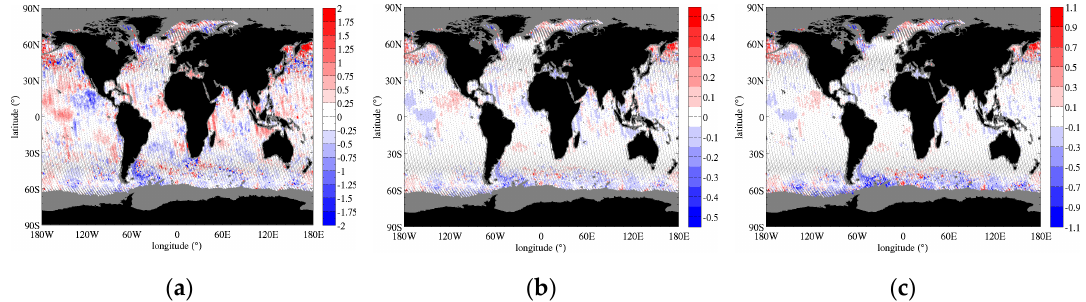
Figure 6. Impact of SST differences on TB and retrieved SSS. ( a ) Map of SST differences ( ◦ C) between OSTIA and NOAA OI interpolated at the Aquarius ground tracks (same week as in ( b ) in Figure 5, ascending orbits). ( b ) Differences in TB (K) for a flat surface due to the differences in SST in the left figure. ( c ) Differences in retrieved SSS (psu) due to differences in TB reported in the middle figure.